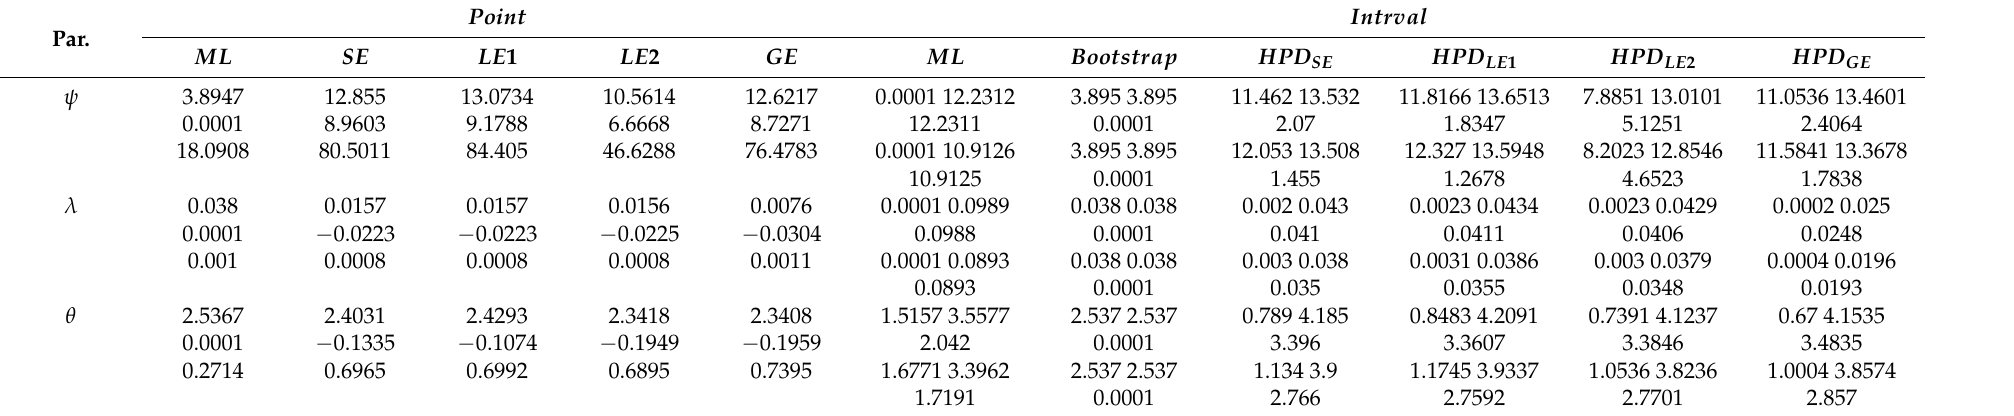
Table 4. The estimation of the parameters ψ , λ , and θ for the open price.